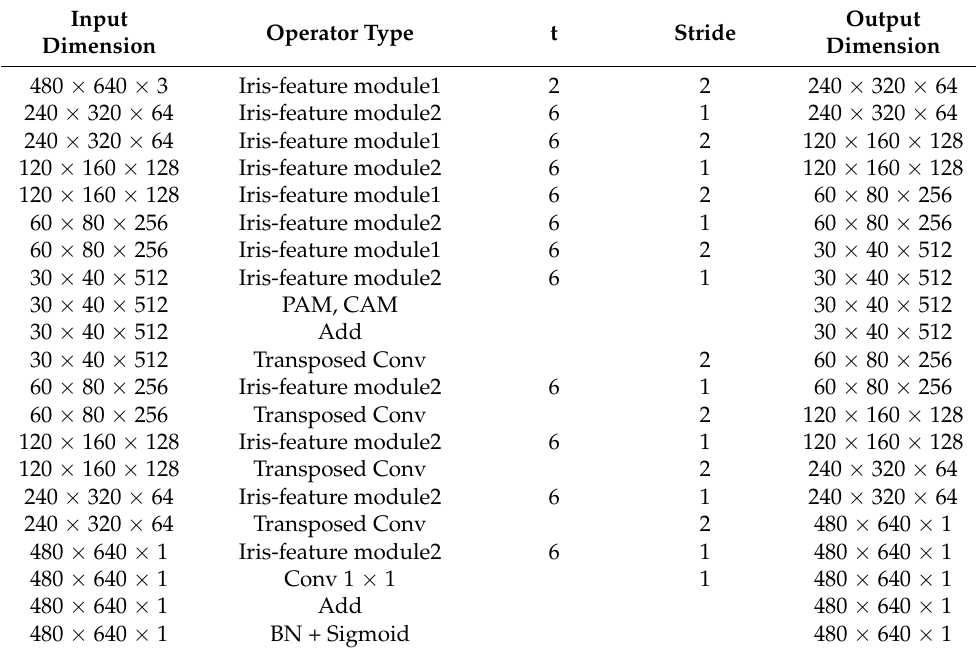
Figure 5. The network structure of PFSegIris. Table 2. Network structure descriptions of PFSegIris. The input image dimension of 480 × 640 × 3 are taken as an